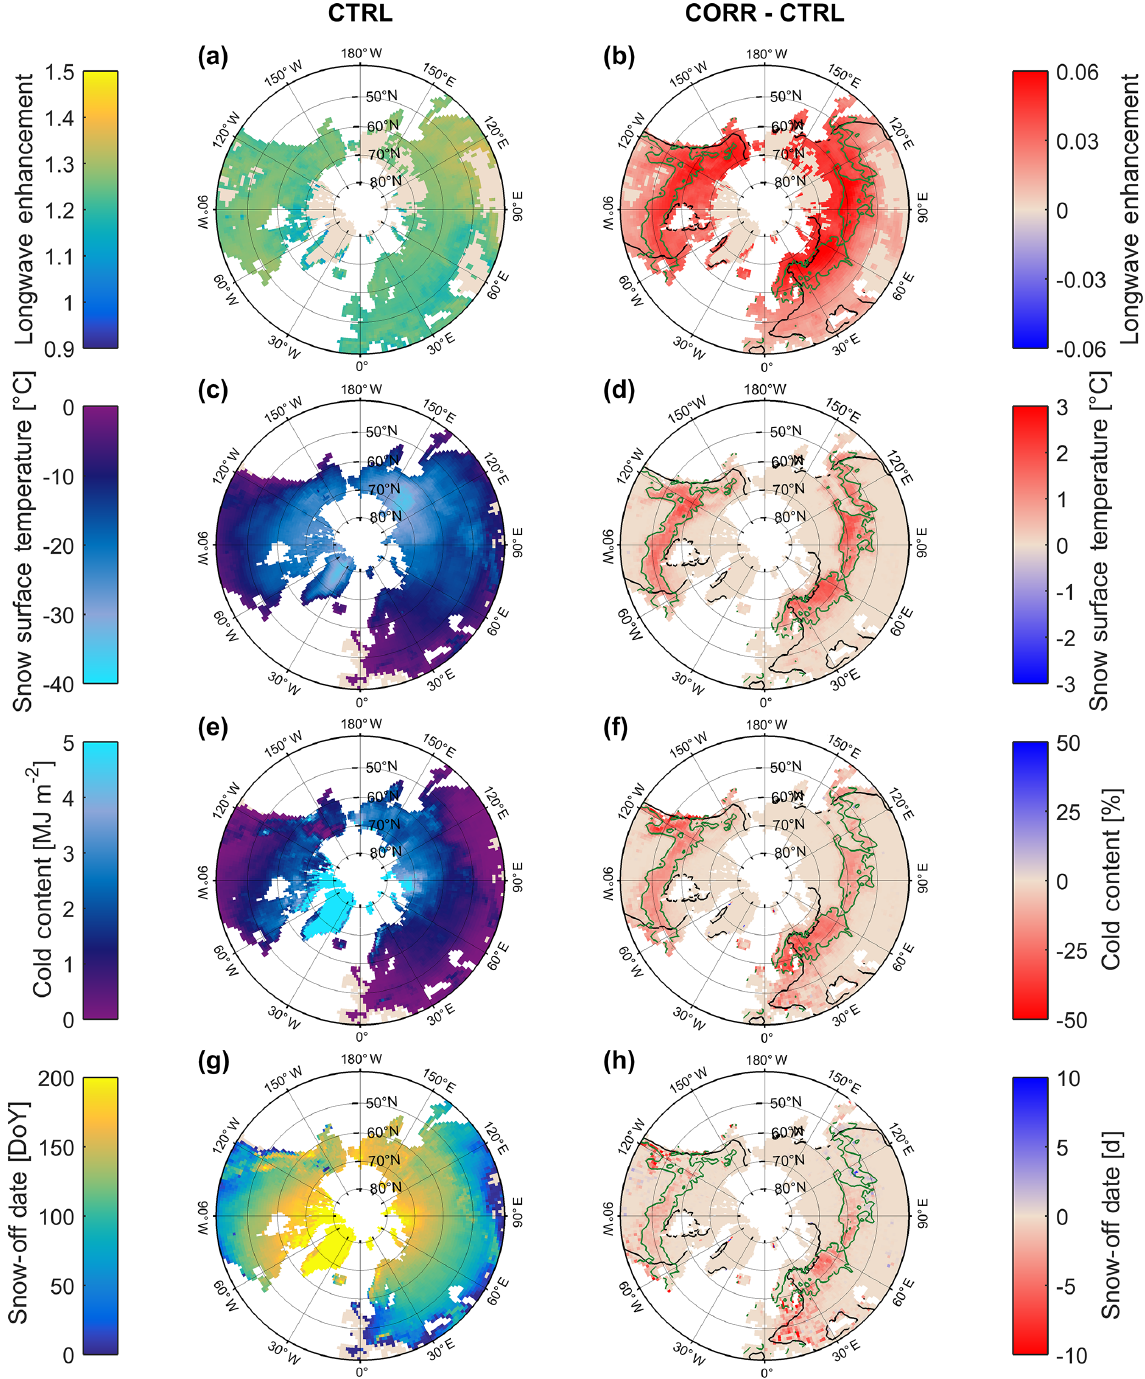
Figure 7. Averages in CTRL (a, c, e, g) and differences between CORR and CTRL (b, d, f, h) for longwave enhancement beneath evergreen needleleaf trees (a, b) , snow surface temperature (c, d) , cold content (e, f) , and snow-off date (g, h) . Longwave enhancement is averaged over December to May, while snow surface temperature and cold content are averaged over entire snow cover seasons. Differences between CORR and CTRL are calculated as averages of differences between each individual snow cover season. For panels (c–h) , a mask is applied to filter out grid cells that are not perennially covered in snow. Black lines demarcate continental areas with less than 10% of overcorrected days. Green lines demarcate areas with coverage by evergreen needleleaf trees of at least